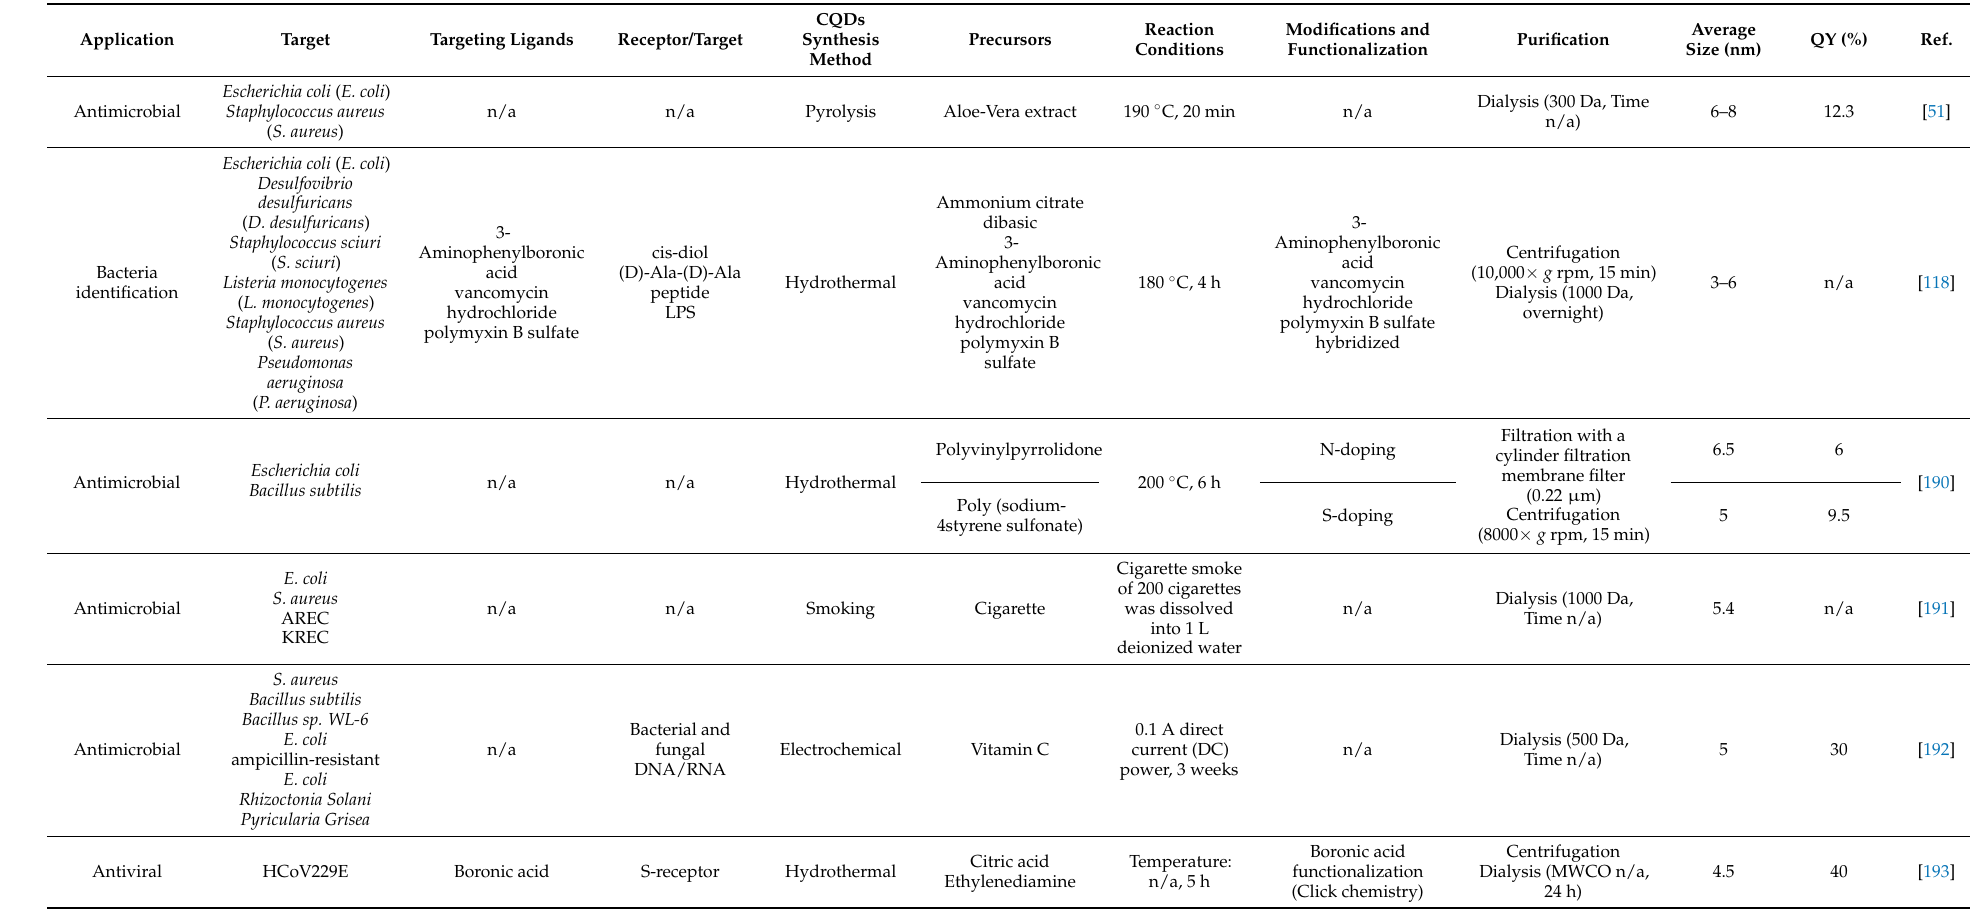
Table 7. Summarized examples of carbon quantum dots used as antimicrobials and